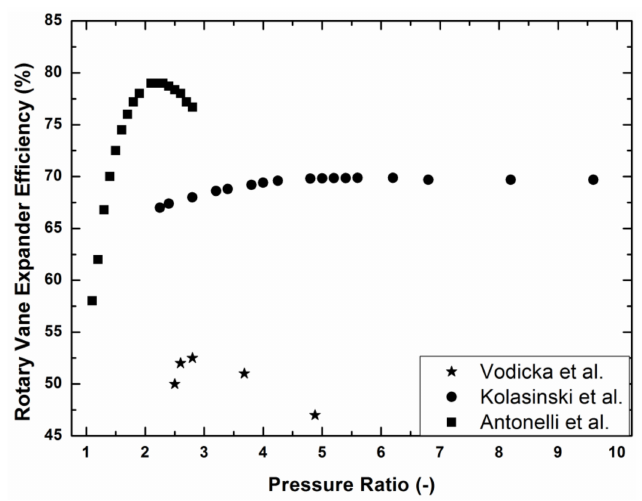
Figure 8. Performance of rotary vane